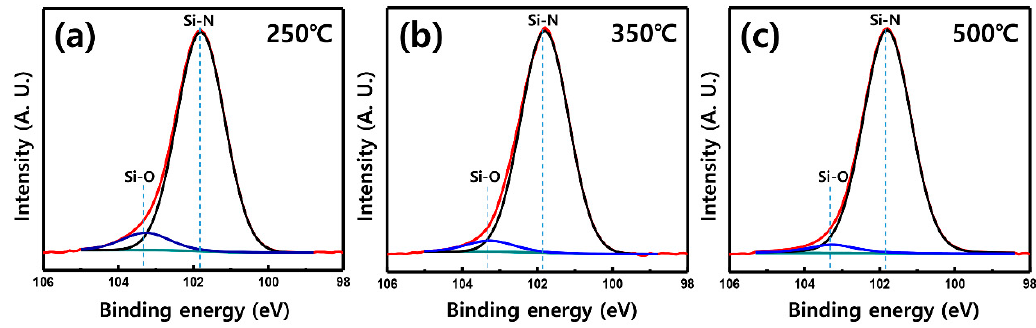
Figure 5. Si 2p peak deconvolution of X-ray photoelectron spectroscopy (XPS) spectra for RPALD SiN x film deposited at ( a ) 250 °C, ( b ) 350 °C, and ( c ) 500 °C.